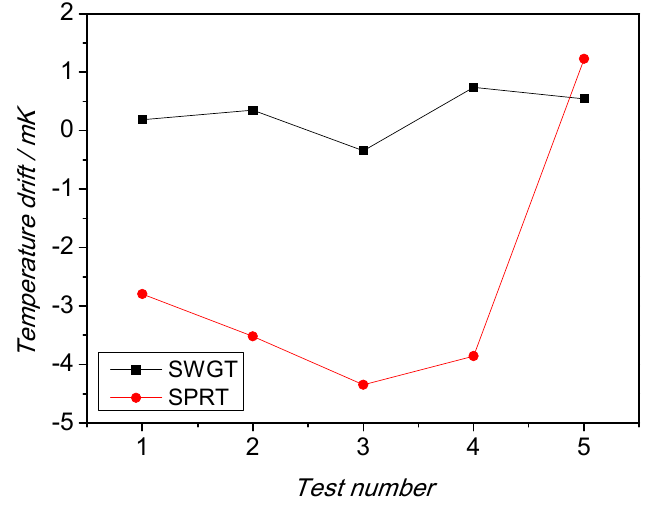
Figure 15. Comparison between the measurement repeatability of SWGT (black squares) and SPRT (red circles). Additionally, in this case the SWGT performs better.